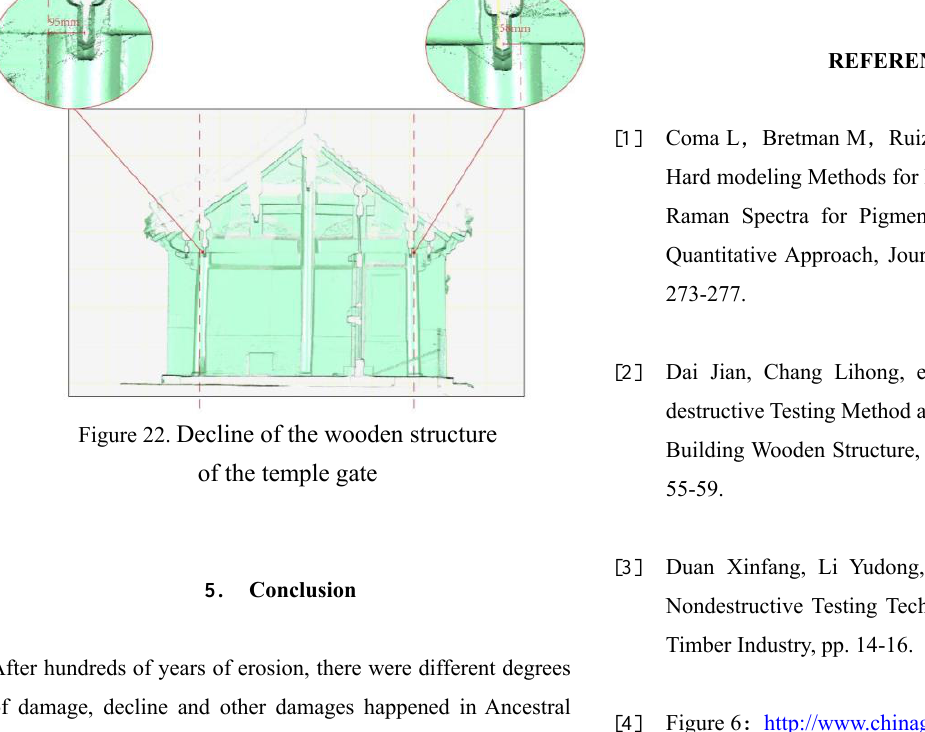
Figure 6 ： http://www.chinagpr.com/uploads/image/